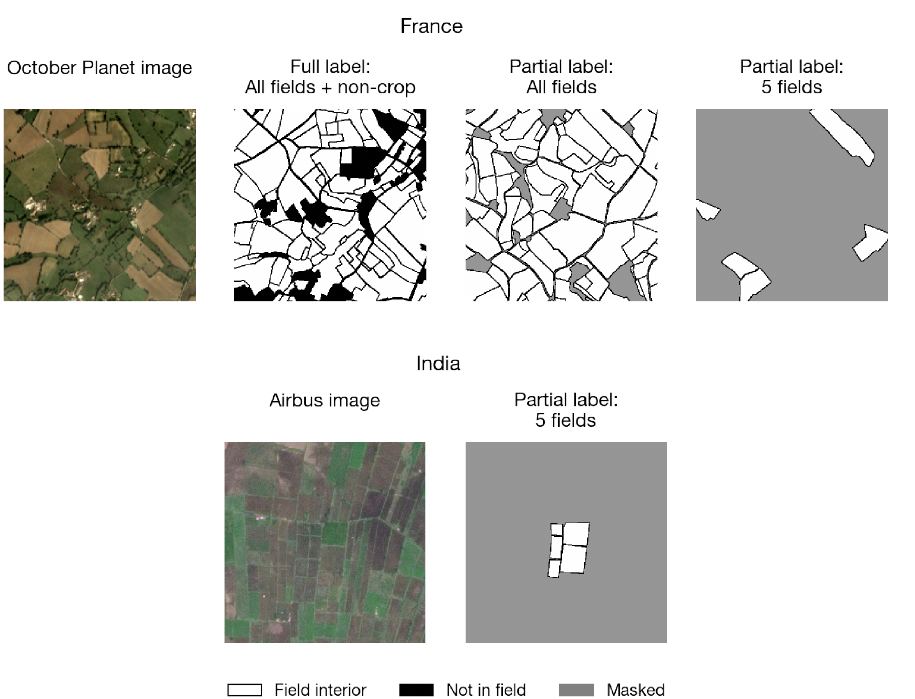
Figure 3. Comparing full labels with partial labels. Usually field delineation is trained on full labels, such as those available in France through the Registre Parcellaire Graphique. In this paper, we instead train on partial labels consisting of a labeled subset of fields and their boundaries. Unlabeled pixels are masked during training. Here we show examples of partial labels for France and India images, and denote masked pixels in